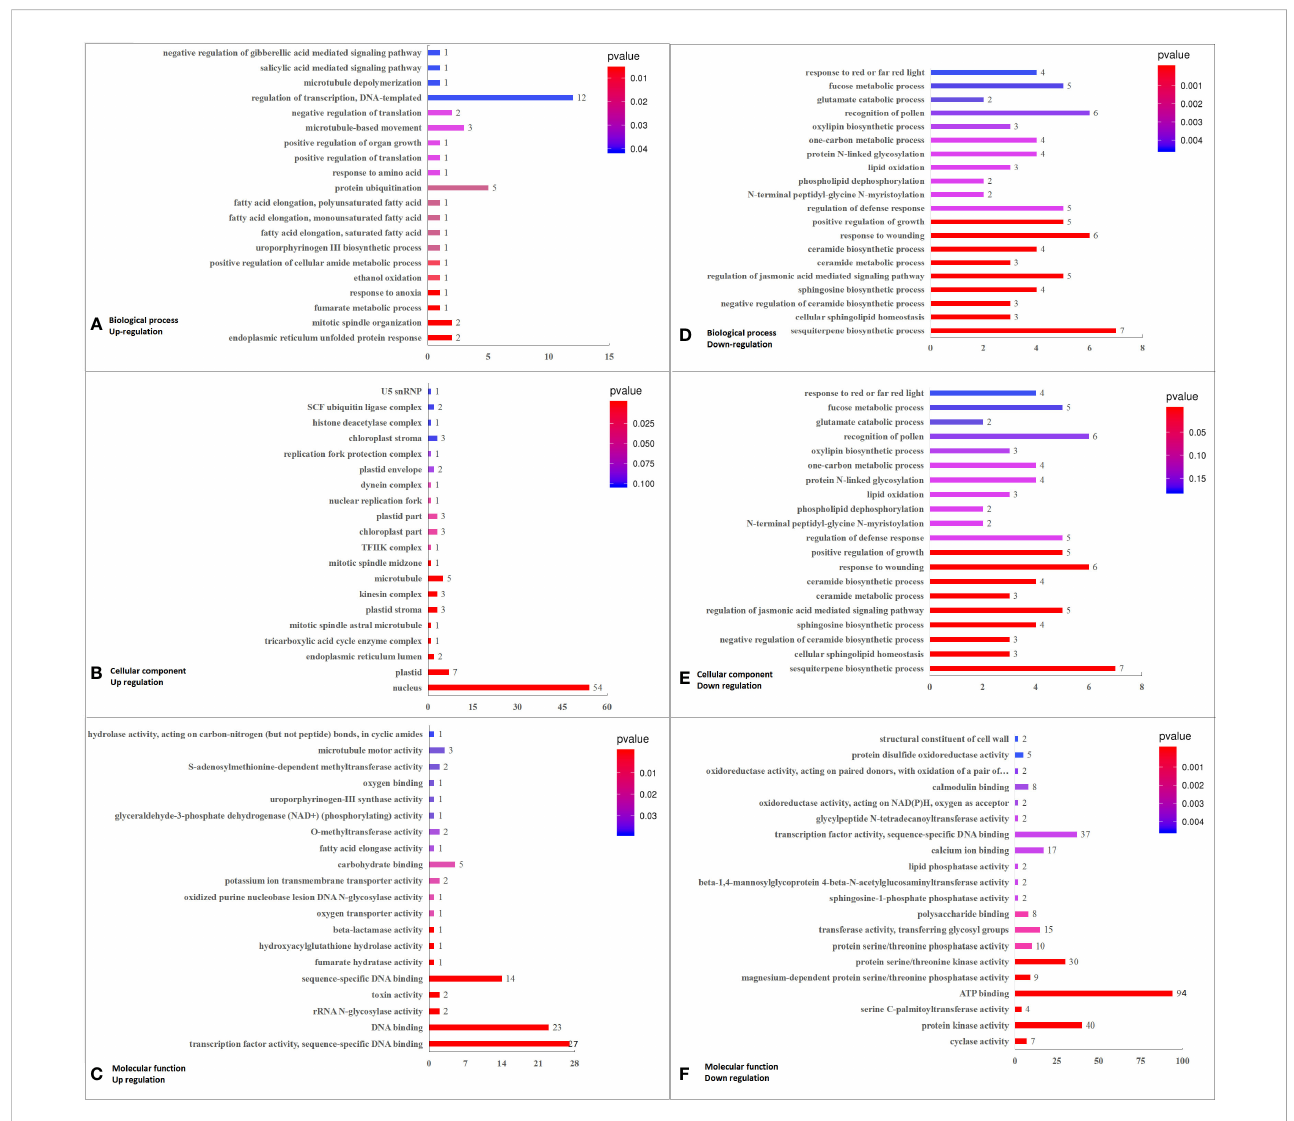
FIGURE 3 Top 20 GO pathways enriched in DEGs in K 0 vs. K ck , including the three categories of BP, CC, and MF. (A) BP terms enriched in up-regulated DEGs. (B) CC terms enriched in up-regulated DEGs. (C) MF enriched in up-regulated DEGs. (D) BP terms enriched in down-regulated DEGs. (E) CC terms enriched in down-regulated DEGs. (F) MF terms enriched in down-regulated DEGs. The X-axis (GeneNum) represents the number of genes of interest annotated in the entry, the Y-axis indicates each term entry. The color of the column represents the P -value of the hypergeometric